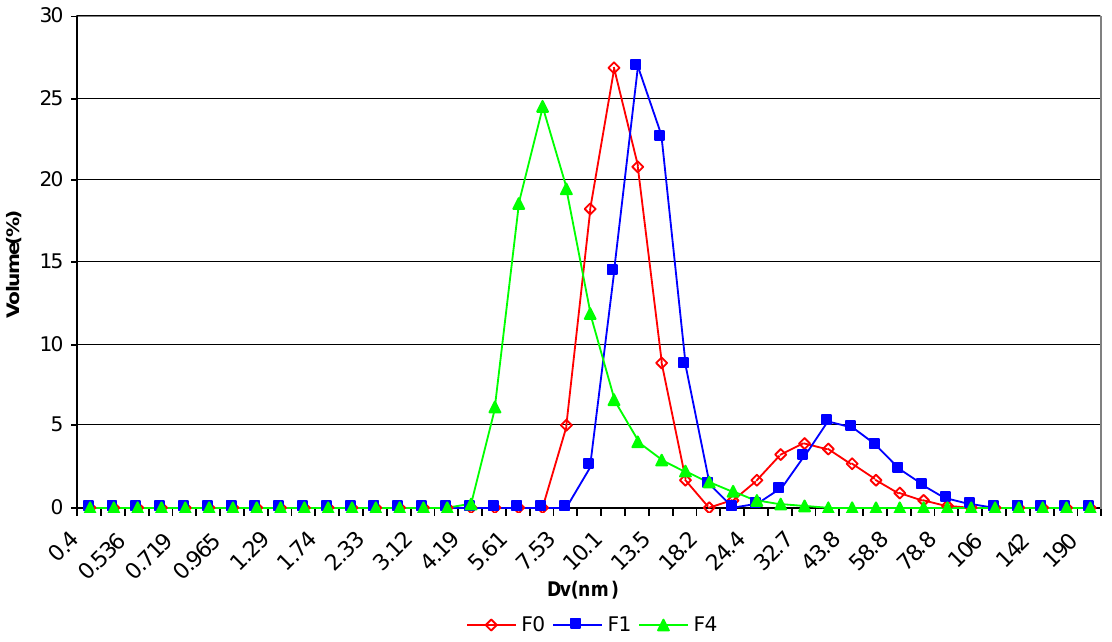
being the non-fractioned sample. 0